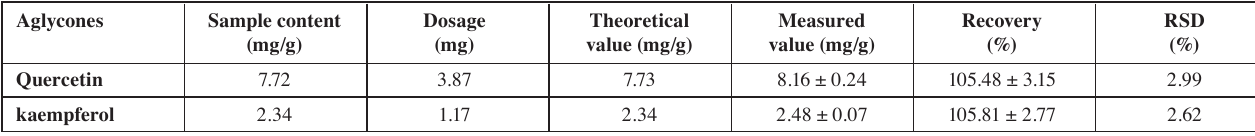
Tab. 3: Recoveries for the extraction of the two aglycones by the UAHAE method Aglycones